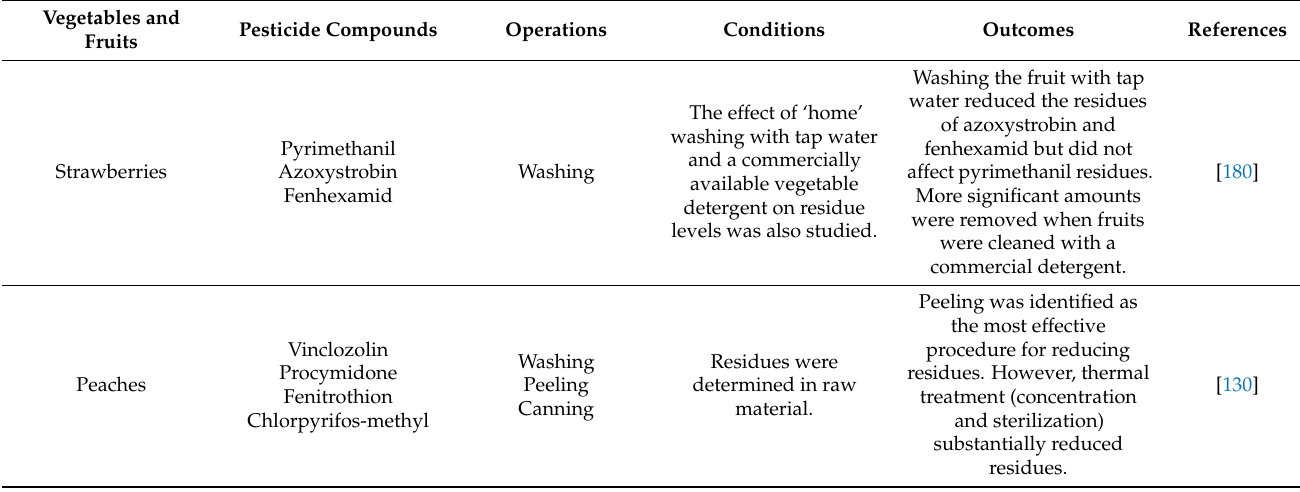
Table 3. Summary of various food processing techniques dealing with the effect of pesticide